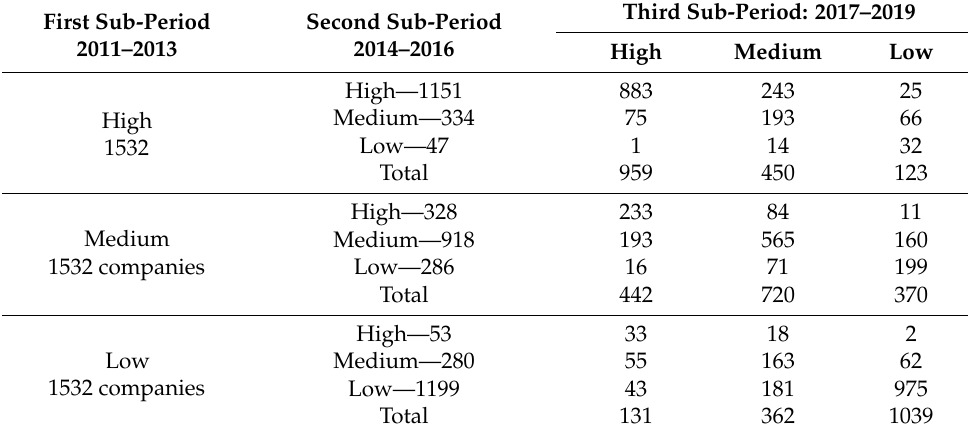
Table 4. Dynamics of solvency risk, 2011–2013 (number of